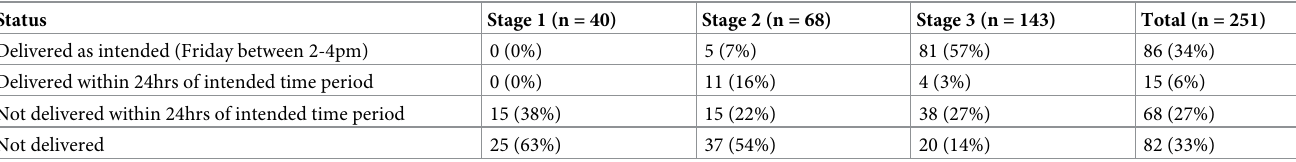
Table 5. SMS delivery status within the intended Friday 2-4pm time period, by stage.